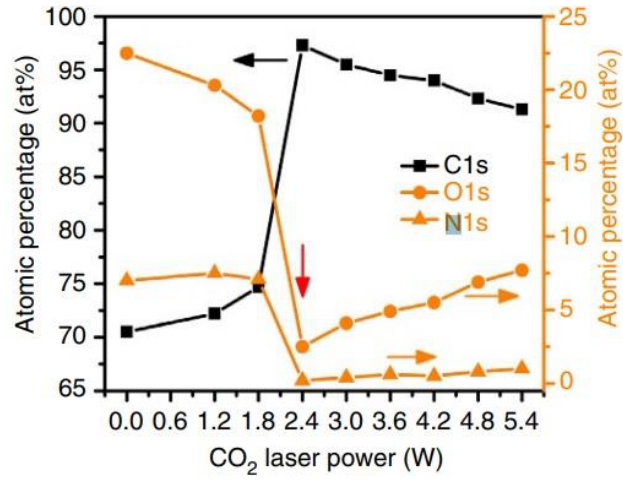
Figure 21. Characterizations of laser induced graphene (LIG) prepared with different laser powers. Atomic percentages of carbon, oxygen and nitrogen as a function of laser power. These values are obtained from high-resolution XPS. The threshold power is 2.4 W, at which conversion from PI to LIG occurs. Reprinted from [303]. Published 2014 by Natio Portfolio as open access.